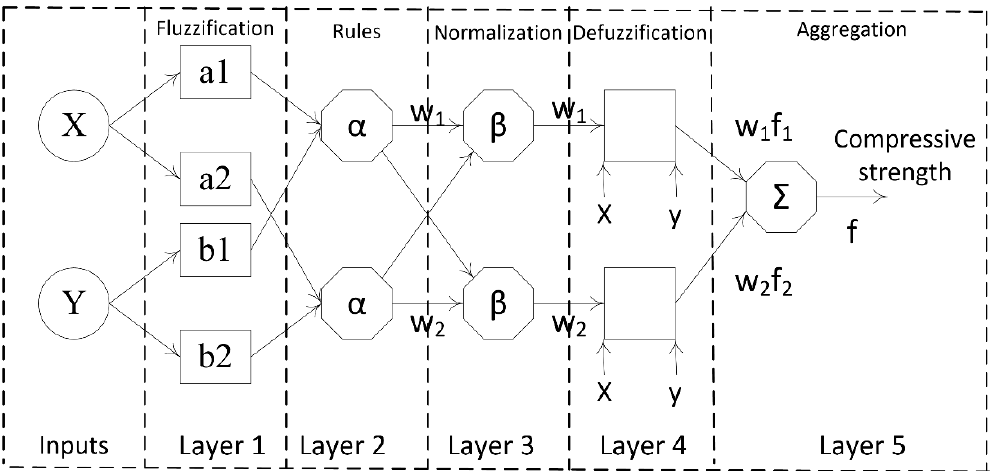
Figure 3. The structure of the adaptive neuro fuzzy inference (ANFIS) algorithm [53]. Reprinted with permission from [53]. 2016, Ziqiang Bi et al.